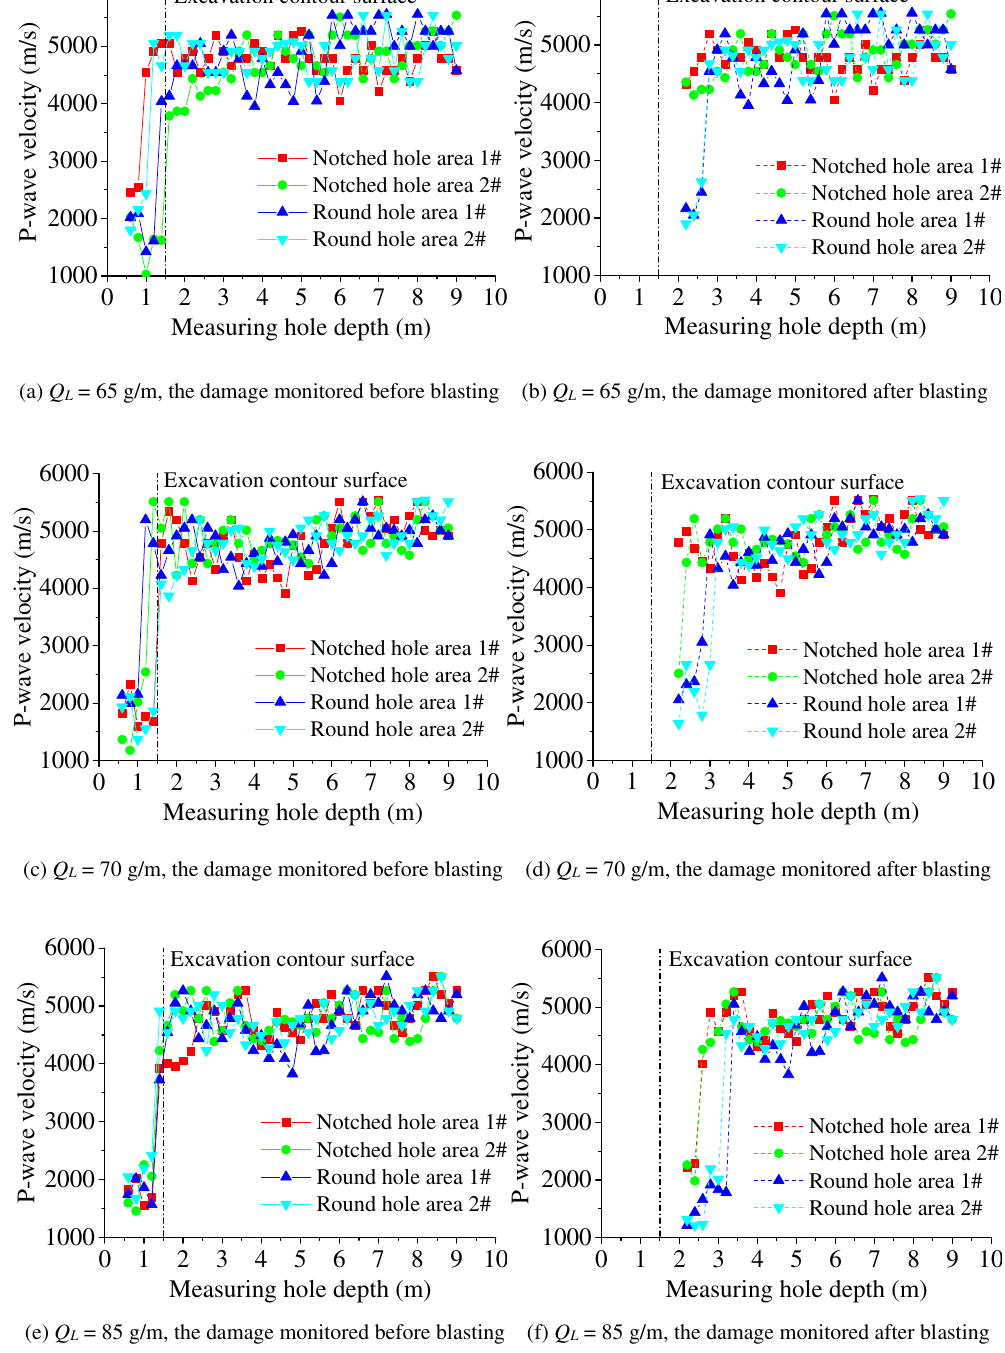
Figure 5. Acoustic wave test data at different linear charging densities before and after